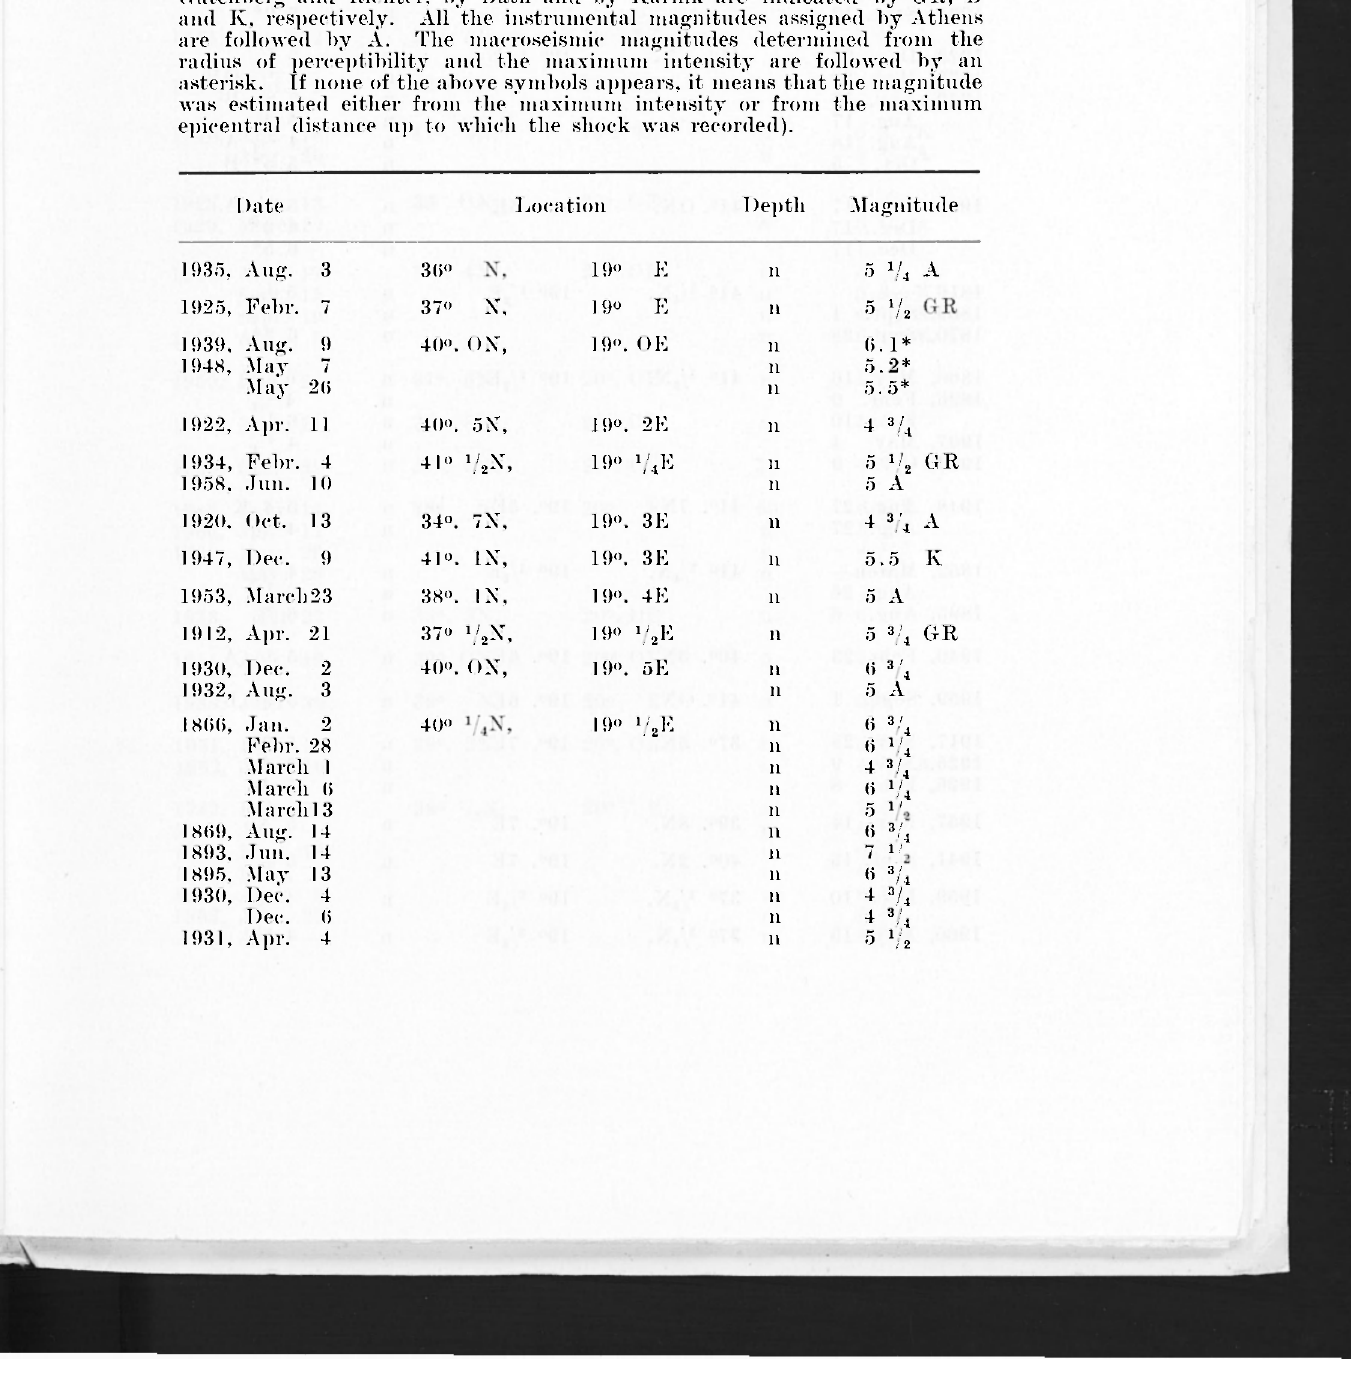
Table I - EARTHQUAKES OF MAGNITUDE JS 4 3 / 4 OCCURRED IN THE GREEK AREA BOUNDED BY THE PARALLELS OF 34° N AND 42° N AND THE MERIDIANS OF 19° E AND 29° E DURING THE PERIOD 1700-1960 (The first coluiim gives the year, month, and date of the shock. The second column gives the coordinates of the epicenter. The accuracy of the deter- mination is indicated by giving the coordinates to full degrees, to half or quarter degrees, or to tenths of a degree. Shocks assigned to the sanie epicenter are listed together. Column 3 gives the focal depth in